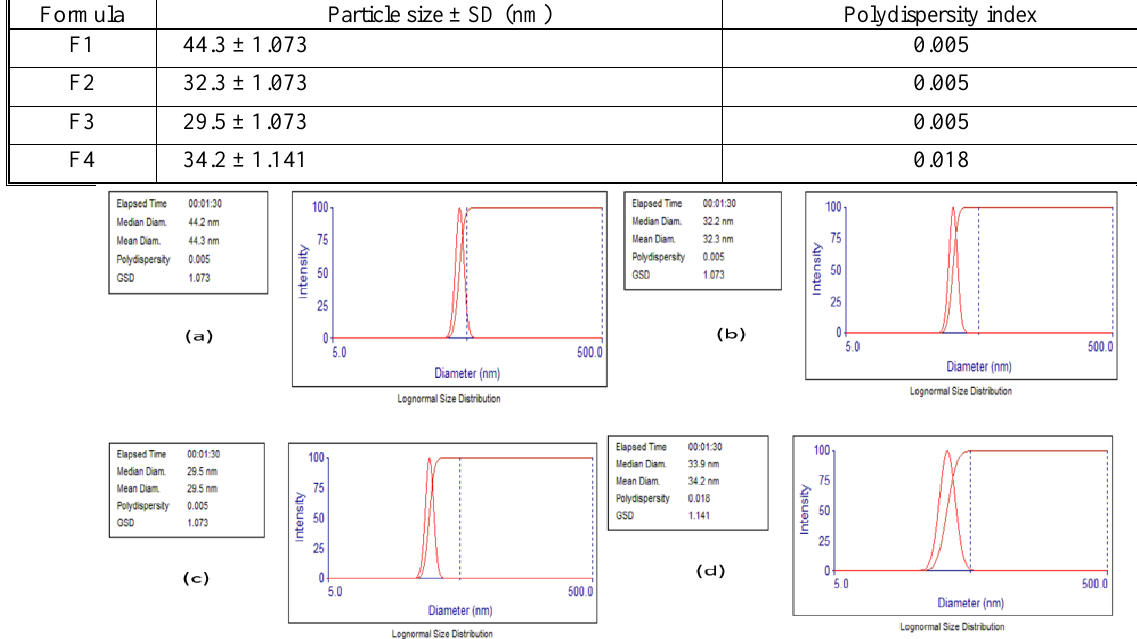
Table 6. Droplet size measurement and polydispersity index (PDI) of tacrolimus liquid self-